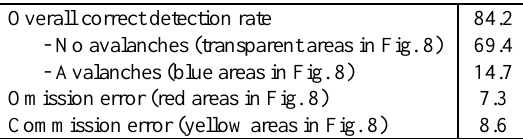
Table 1. Accuracy (in percent) of the avalanche classification algorithm versus the manual digitizing method in one of the randomly selected test areas (orange rectangle in Figure 4).